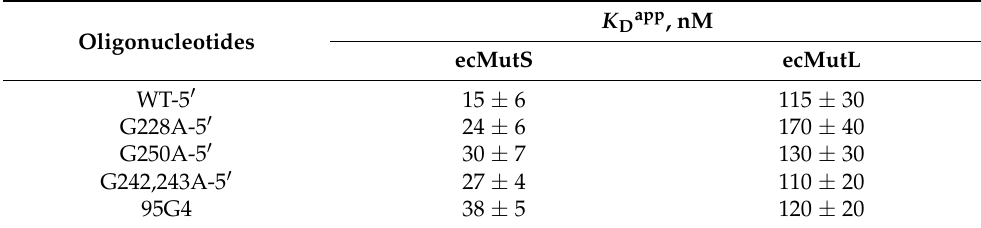
Figure 7. Binding of ecMutS ( a ) and ecMutL ( b ) to ssDNA models containing G4 motifs. Representa- tive electropherograms of ecMutS and MutL binding to hTERT G4s, including G250A ‐ 5 ′ and WT ‐ 5 ′ , respectively, are shown above. Below, the yield of nucleic acid–protein complexes, as calculated from the data of the EMSA, is plotted against the total protein concentration: 0–160 nM per ecMutS dimer or 0–700 nM per ecMutL dimer at 5 nM DNA or 20 nM DNA, respectively. Table 1. Apparent dissociation constants of ecMutS and ecMutL complexes with ssDNA models containing G4